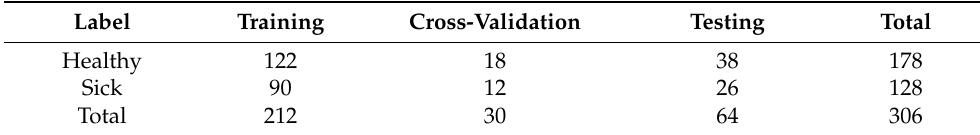
Table 2. Details of training, cross-validation, and testing dataset for the classification model. Label